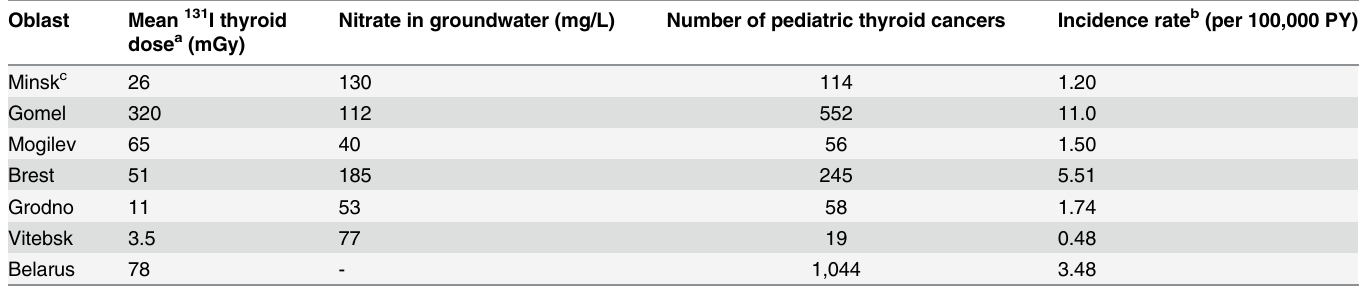
Table 1. Mean thyroid dose from 131 I, nitrate in groundwater, number of pediatric thyroid cancers, and incidence rate of pediatric thyroid cancer among Belarusians 0 – 18 years old at the time of the Chernobyl accident. Oblast Mean 131 I